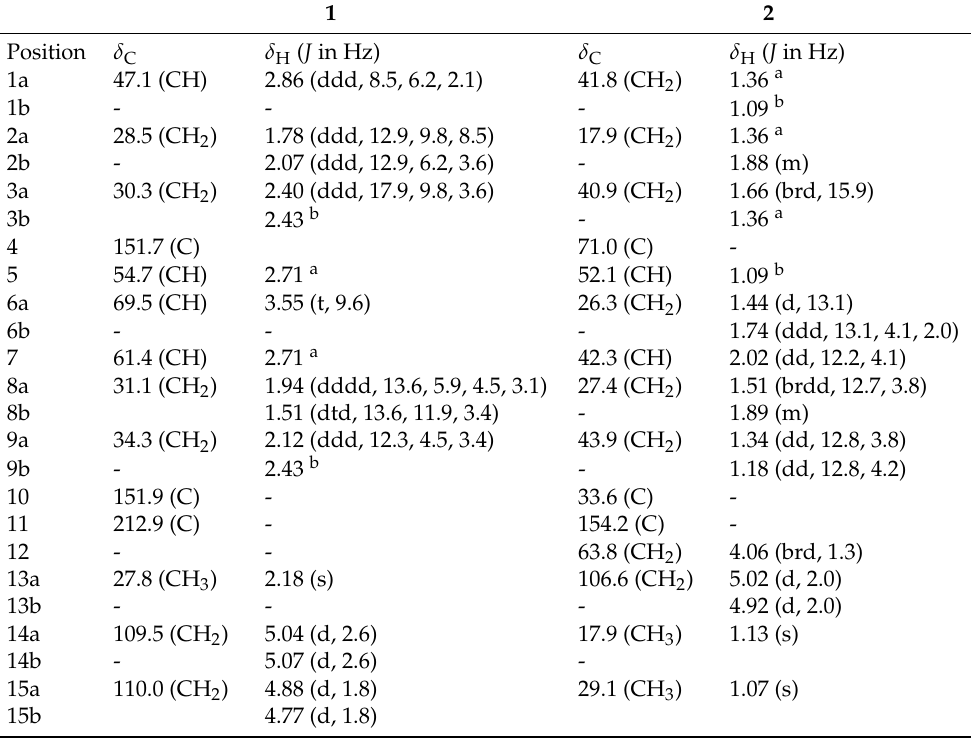
Table 1. 1 H and 13 C NMR data for Compounds 1 and 2 (MeOH- d 4 ), 600 MHz, J in Hz).